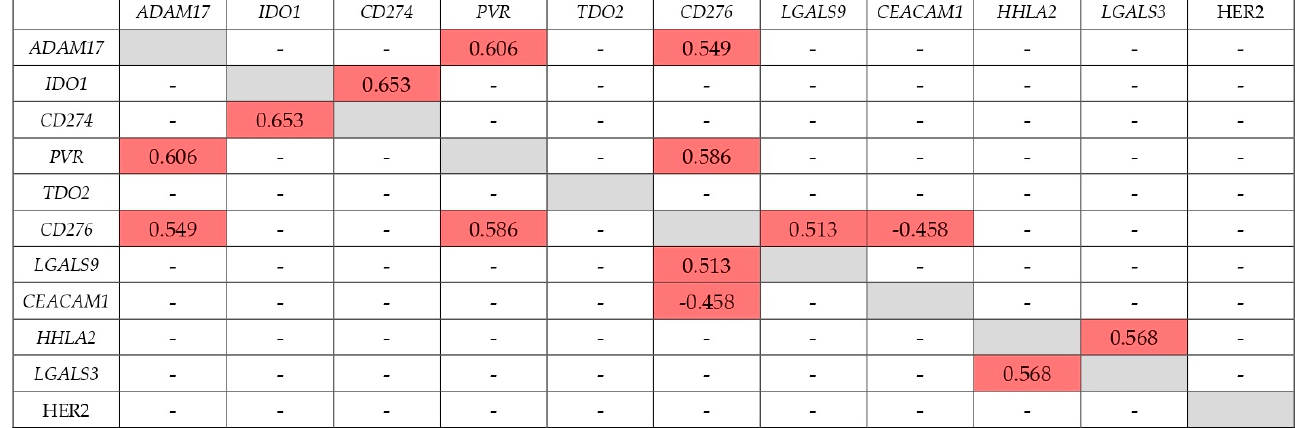
Figure 3. Correlation of expression at stage IV (metastatic GC). significant correlation; there is no